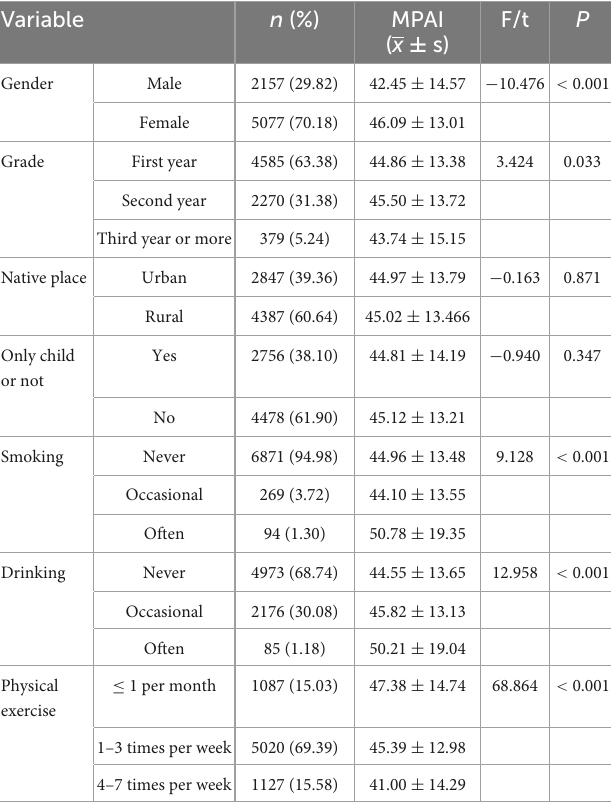
TABLE 1 Mobile phone addiction scores of college students with different